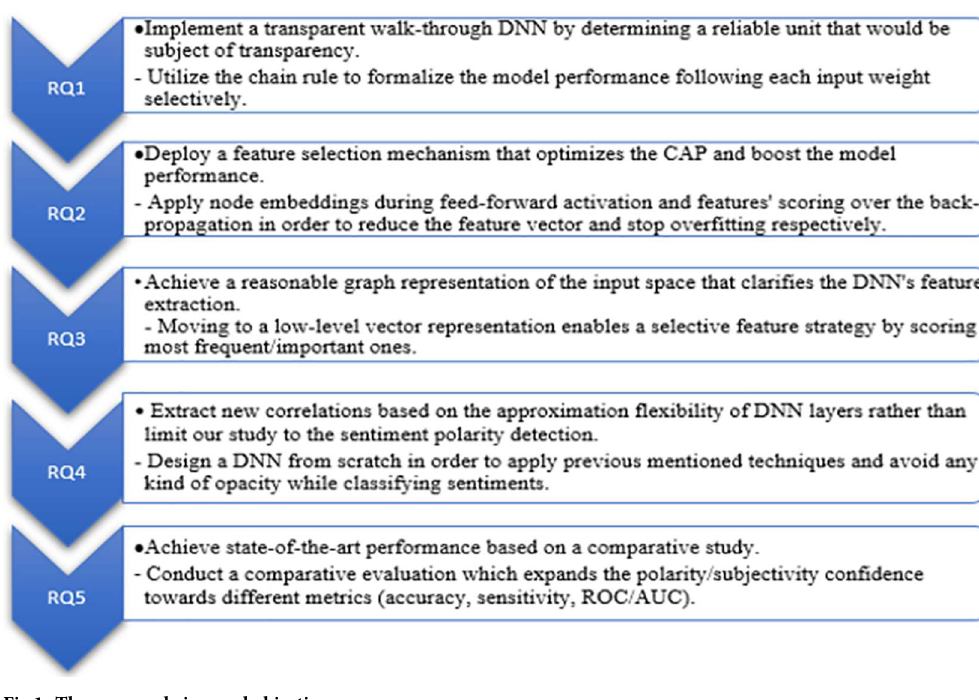
Fig 1. The proposed aims and